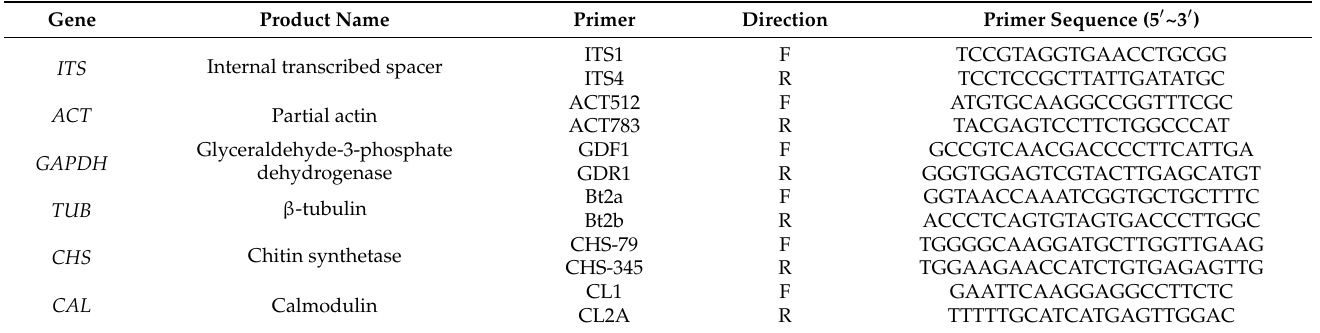
Table 2. Primers used for PCR